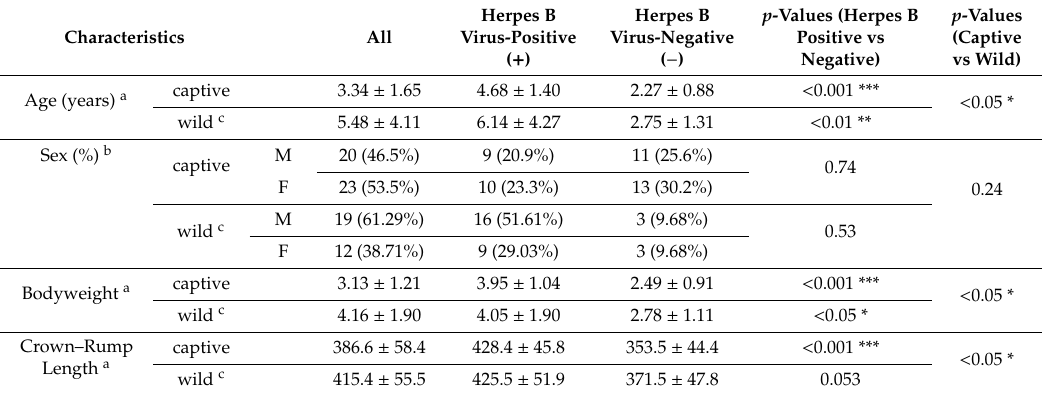
Table 1. Basic characteristics of macaque samples in viral metagenomic sequencing.